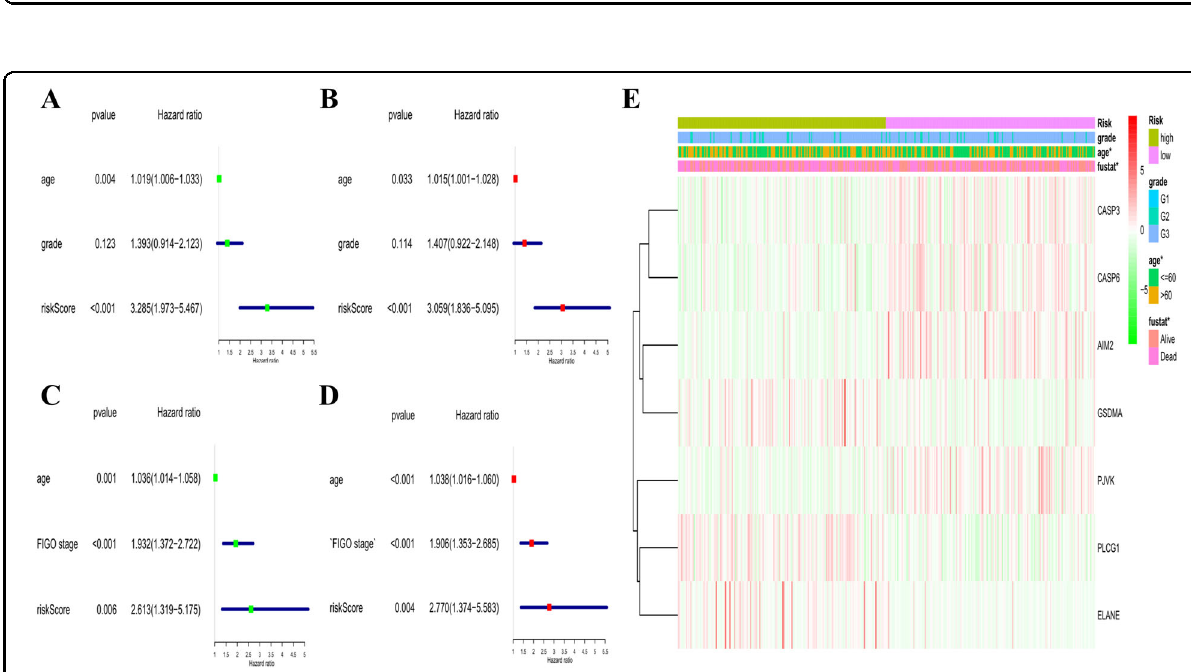
Fig. 5 Univariate and multivariate Cox regression analyses for the risk score. A Univariate analysis for the TCGA cohort (grade: the degree of tumour differentiation, G1 to G3). B Multivariate analysis for the TCGA cohort. C Univariate analysis for the GEO cohort (FIGO stage: I to IV). D Multivariate analysis for the GEO cohort. E Heatmap (green: low expression; red: high expression) for the connections between clinicopathologic features and the risk groups (* P <